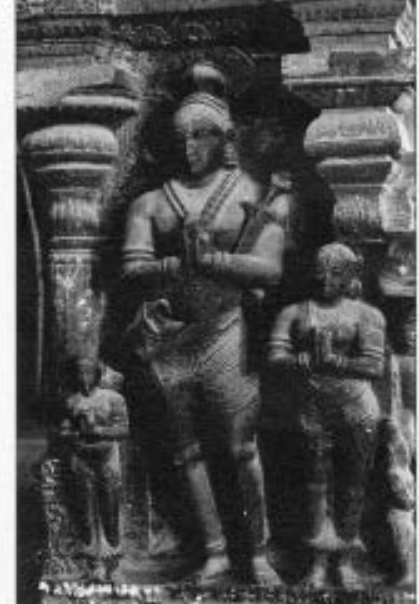
Figure 9 The Ramasvamy temple: sculp­ ture on the central pillar of the entrance doorway depicting the royal patron Raghu­ natha Nayaka with